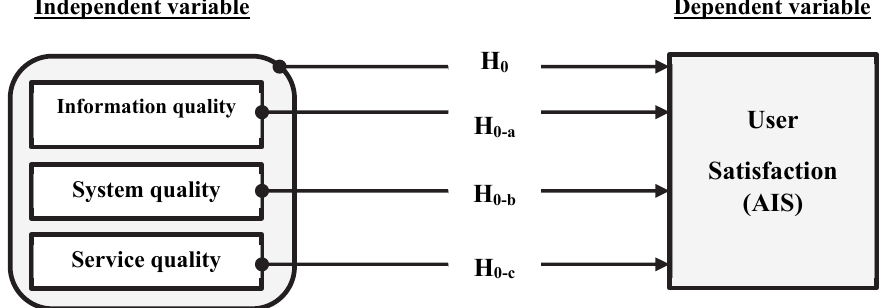
Fig. 1. The relationship between the variables of the study (while using information from DeLeone & McLean,